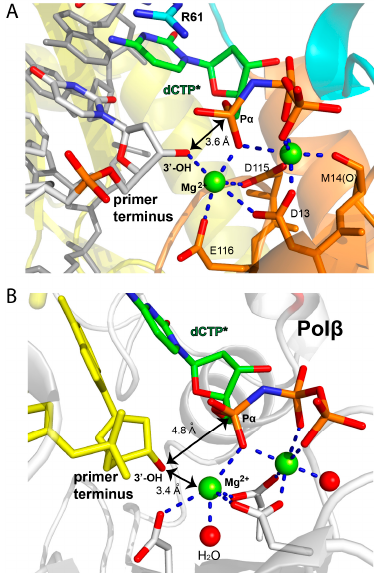
Figure 6. Metal coordination of polymerase-Fm7dG:dCTP* ternary structures. ( A ) Coordination of the catalytic and nucleotide-binding metal ions in the pol η -Fm7dG:dCTP* structure. The distance between the 3 (cid:48) -OH of the primer terminus and the P α of dCTP* is indicated as a double-headed arrow. The